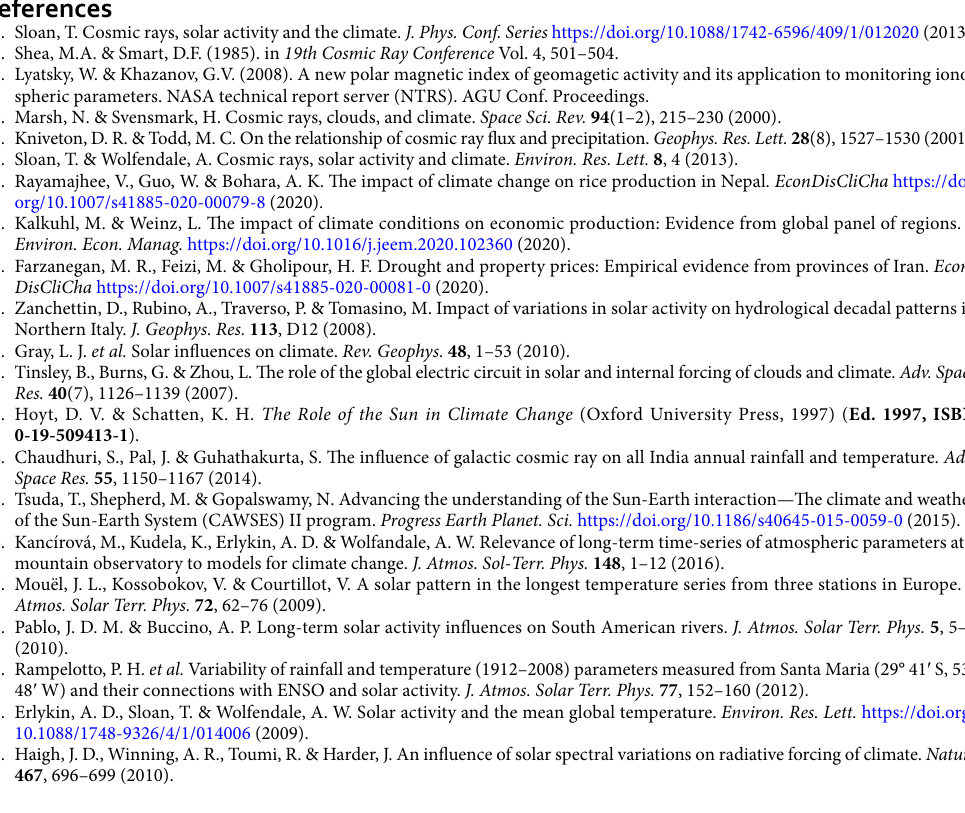
Table 3. SSN exhibited very negligible, weak influence on SAT and Rainfall in the study area during the period under investigation. Furthermore, a regression of Geomagnetic aa-index on SAT and Rainfall yielded an average 0.145%, and 0.125% respectively as shown in Table 4. Our models show that the variability of SAT and Rainfall in Wet Zone West Africa during Solar Cycles 22–24 are far less than 1%. With R 2 < 0.001, the influence of SSN and Geomagnetic aa-index on SAT and Rainfall is less than 1%; which could cause ‘very small’ effect. These weak percentage impacts prove that the variability of SAT and Rainfall were most probably not effected by SSN and Geomagnetic aa-index. Consequently, the variability of SAT and Rainfall in Wet Zone West Africa cannot be attributed to SSN and Geomagnetic aa-index. We therefore, attempt to conclude that variability in climate parameters in the Wet Zone West Africa is most probably not caused by solar magnetic activity, but could be attributed to anthropogenic